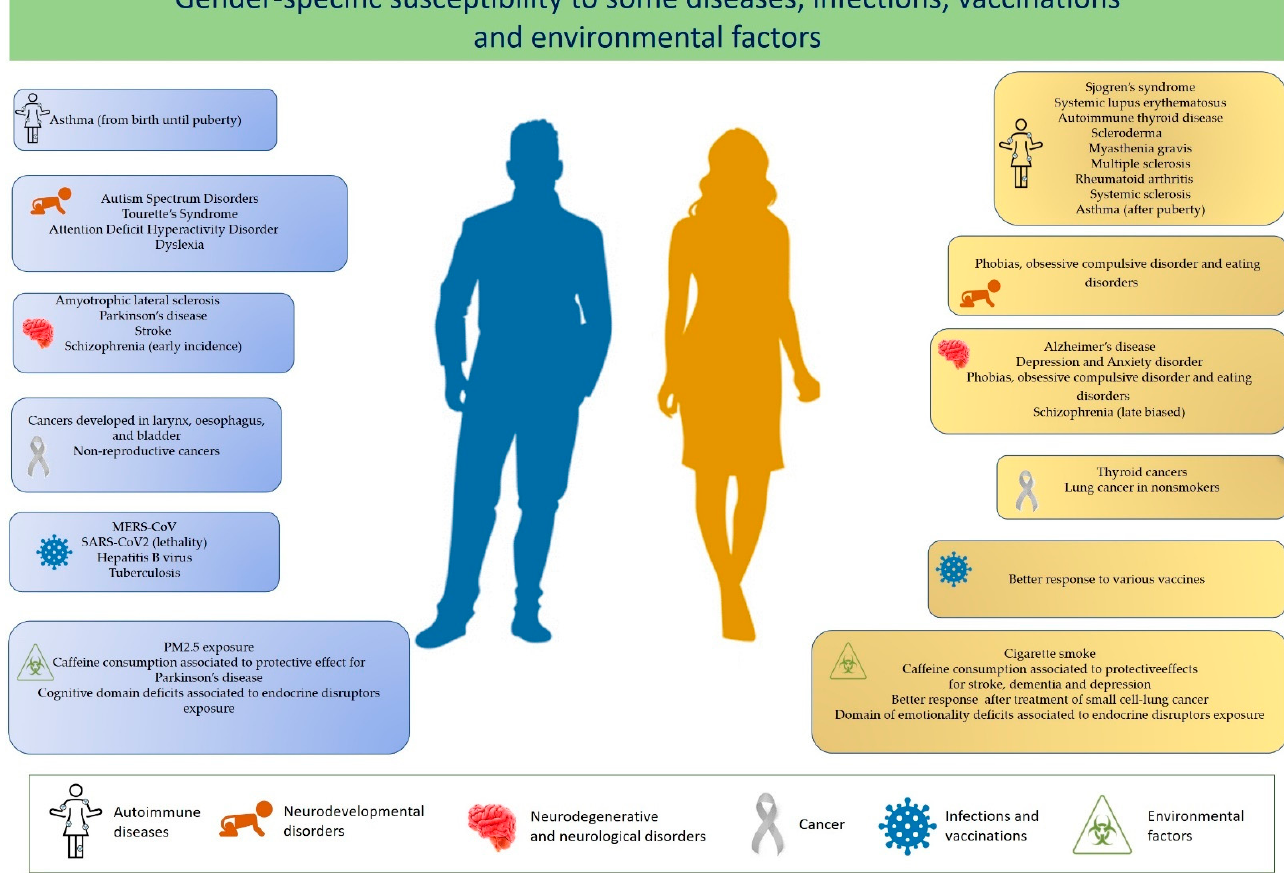
Figure 1. Increased susceptibility to some diseases and infections and to the effects of vaccinations and environmental factors in males (left panels) and females (right panels).